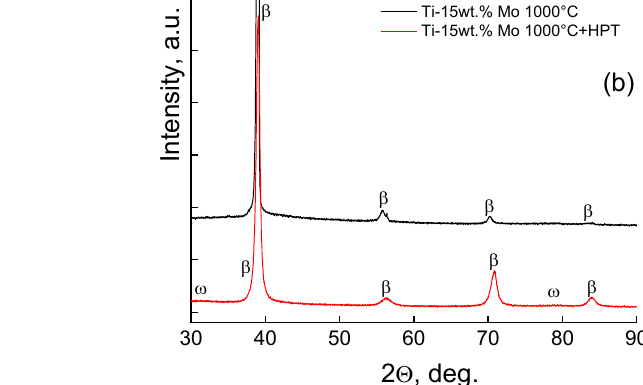
2 , deg. Figure 4. XRD patterns for the ( a ) Ti – 1.5 wt.% Mo and ( b ) Ti – 15 wt.% Mo alloys; black curves (top ones) correspond to the samples annealed at 1000 °C before HPT, red curves (bottom ones) correspond to the annealed samples after HPT. Table 2. Phase composition, lattice parameters, phase fraction, and the average grain size for each phase for the Ti – 1.5 wt.% Mo and Ti – 15 wt.% Mo alloys annealed at 1000 °C for 24 h and subjected to HPT.